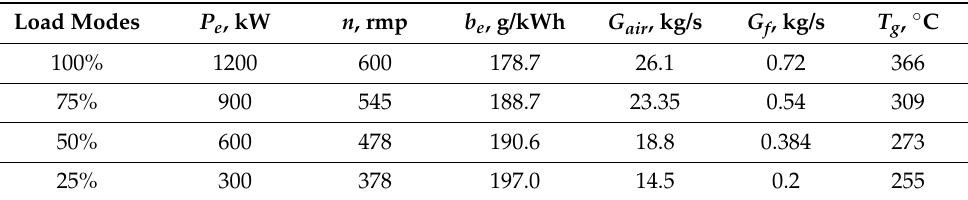
Table 2. Specifications for the medium-speed four-stroke parameters at the specific test-type E3 cycle load modes of ISO 8178.